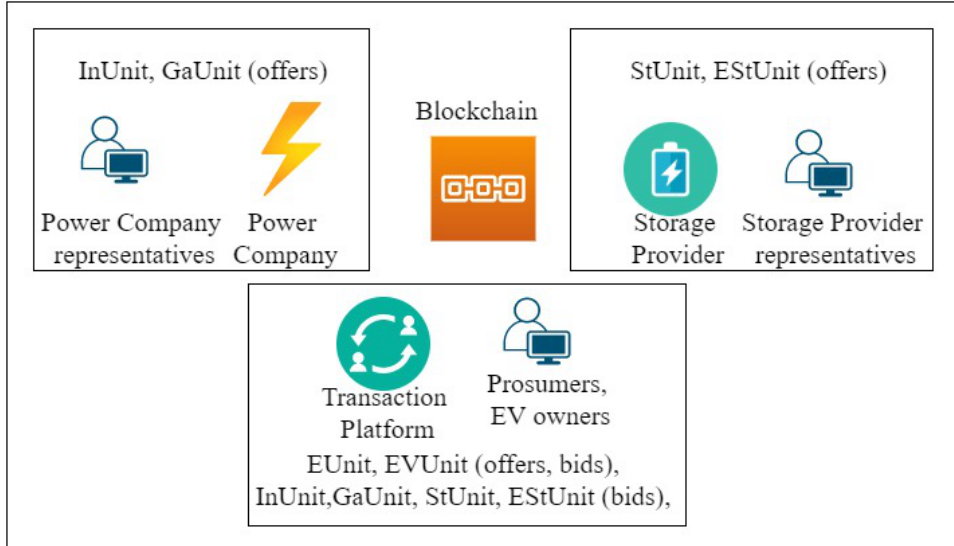
Figure 1. System